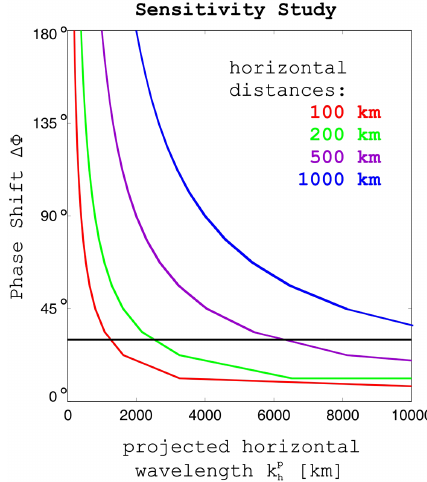
Fig. 5. Sensitivity study for the method introduced by Ern et al. (2004) concerning the resulting wavelength ( k p zontal distances and phase